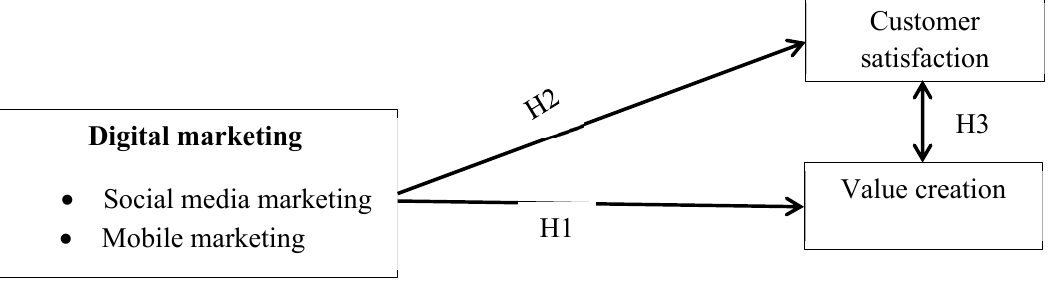
Fig. 1. Conceptual Research